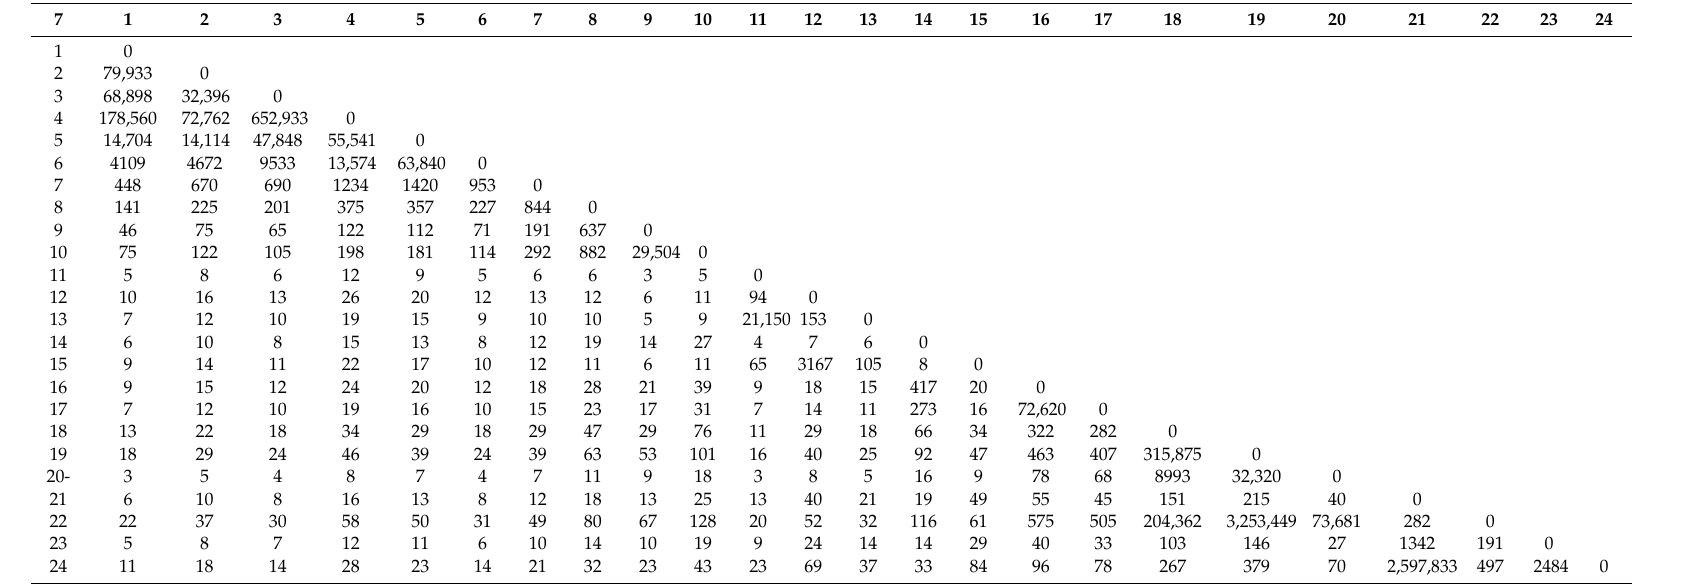
Table 7. Interaction matrix between source patches based on gravity